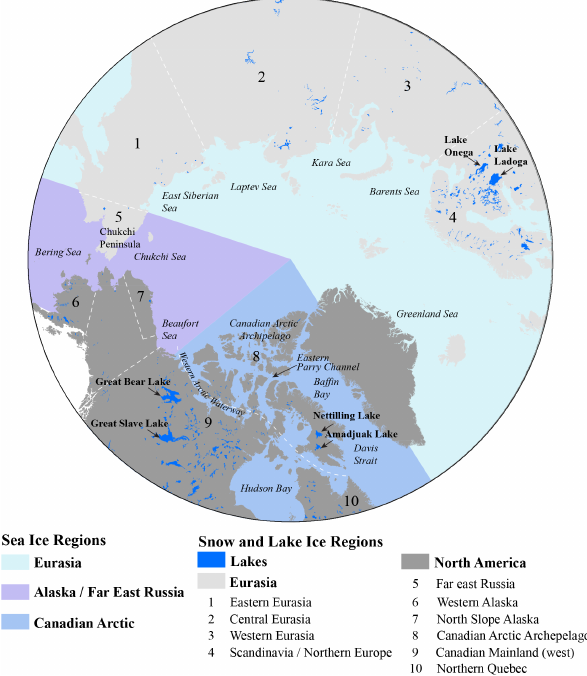
Figure 1. Map of the study area, including the main sea ice, snow and lake ice regions (coloured), and subregions (numbered) in- cluded in Table